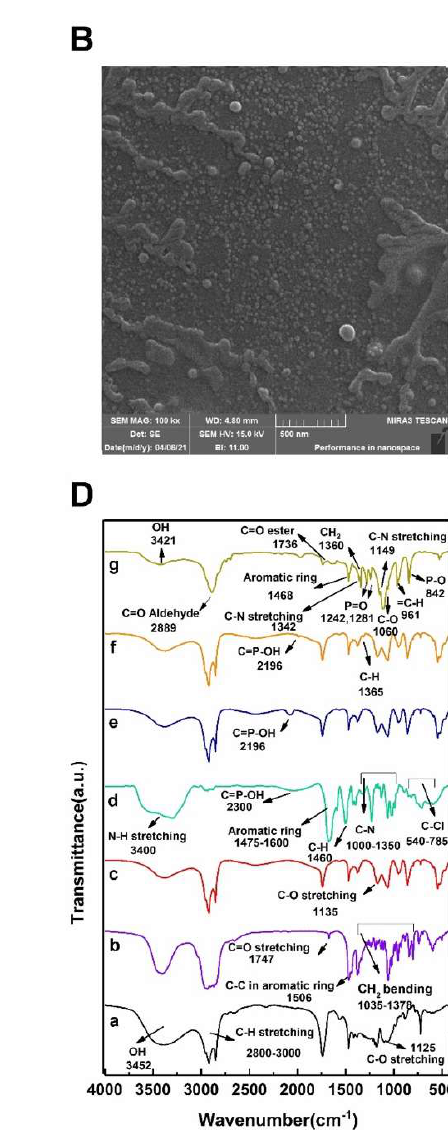
Figure 2. ( A ) Particle size distribution of Niosome (Nio), Cyclophosphamide-loaded niosome (Nio-Cyclo), and PEGylated Cyclophosphamide-loaded niosome (Nio-Cyclo-PEG) formulations obtained by DLS. ( B ) Morphological assessment of the best Nio-Cyclo formulation using scanning electron microscopy (SEM), and ( C ) transmission electron microscopy (TEM); ( D ) FTIR spectra of ( a ) Span60, ( b ) Cholesterol, ( C ) Niosome, ( d ) Cyclophosphamide, ( e ) Nio-Cyclo, ( f ) Nio-Cyclo-PEG, and ( g ) PEG 2000.